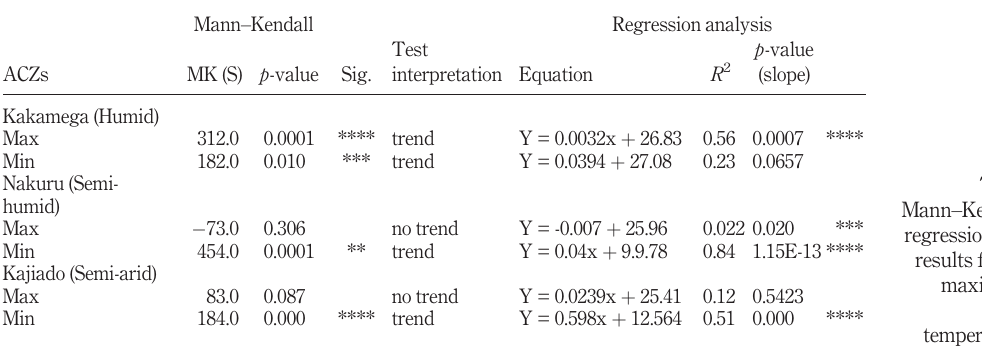
Table X. Mann–Kendall